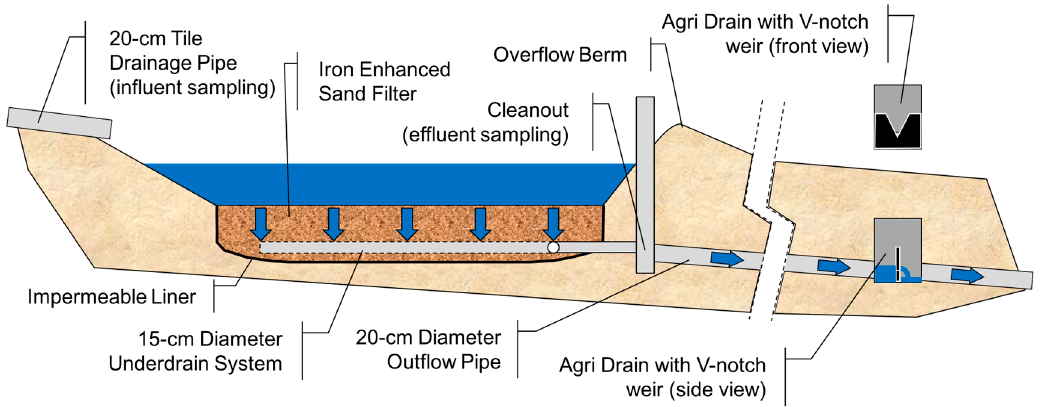
Figure 2. Iron enhanced sand filter (IESF) schematic with relative location of Agri Drain and V-notch weir (not to scale).